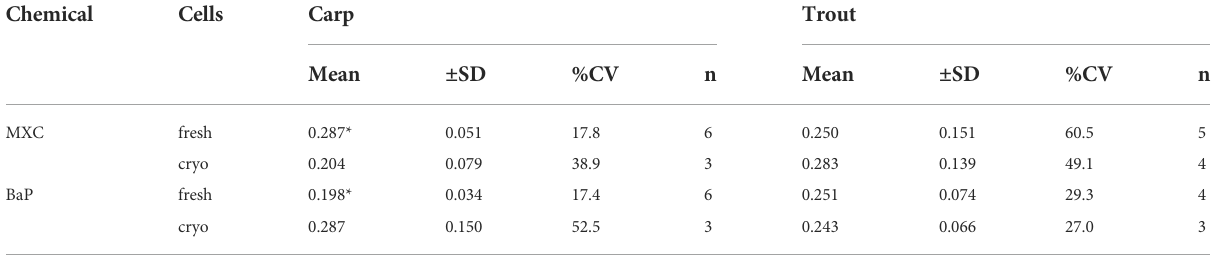
TABLE 2 Mean in vitro intrinsic clearance (CL in vitro, int, mL/h/10 6 cells) 1) of methoxychlor (MXC) and benzo[a]pyrene (BaP) in freshly isolated and cryopreserved common carp and rainbow trout hepatocytes. Chemical Cells